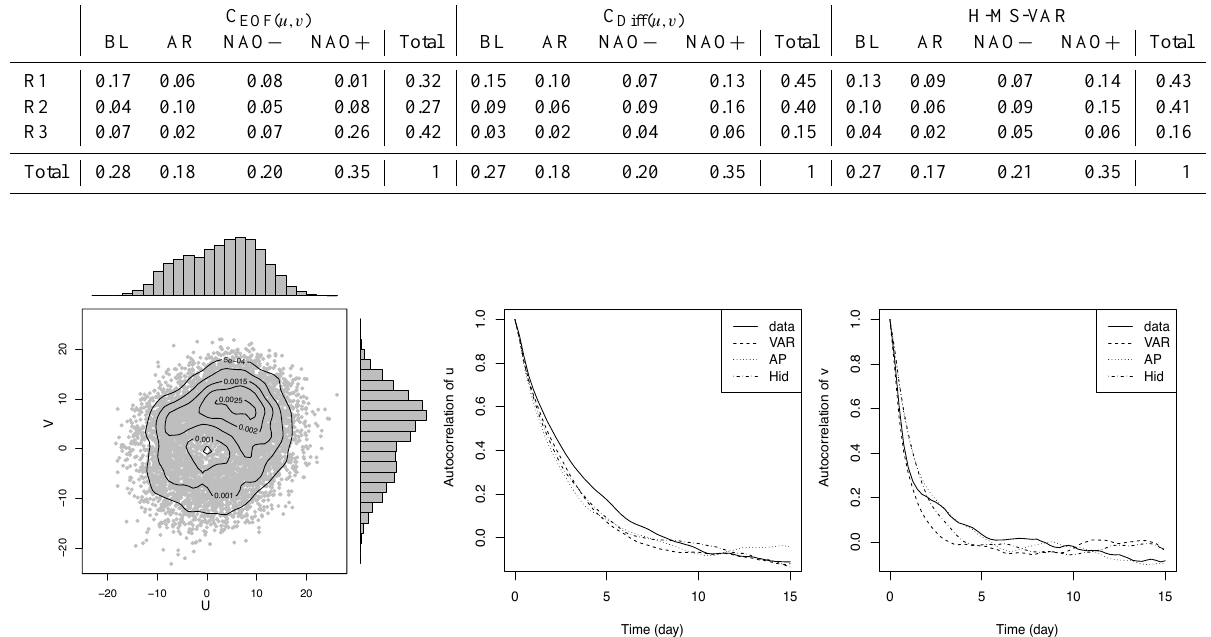
Figure 8. Left: joint and marginal distributions of simulated data at site 10 from the model H-MS-VAR. Central and right panels: autocorre- lation functions of { u t } and { v t } at site 10 for the reference data, and simulated data from the VAR(2), AP-MS-VAR C